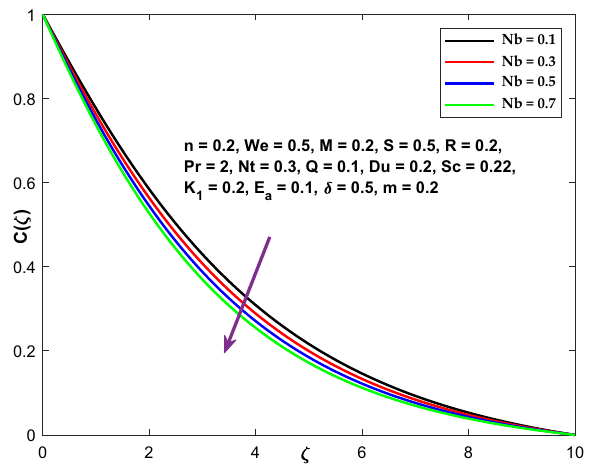
Figure 18. Character of Nb versus C (ζ)